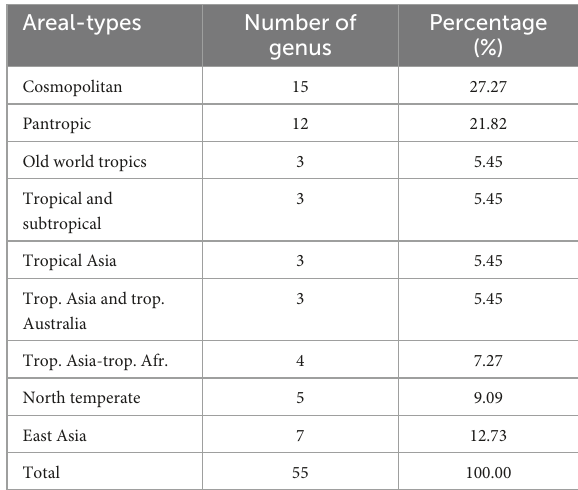
TABLE 1 Genus areal types of herbaceous vascular plants in Gutianshan subtropical